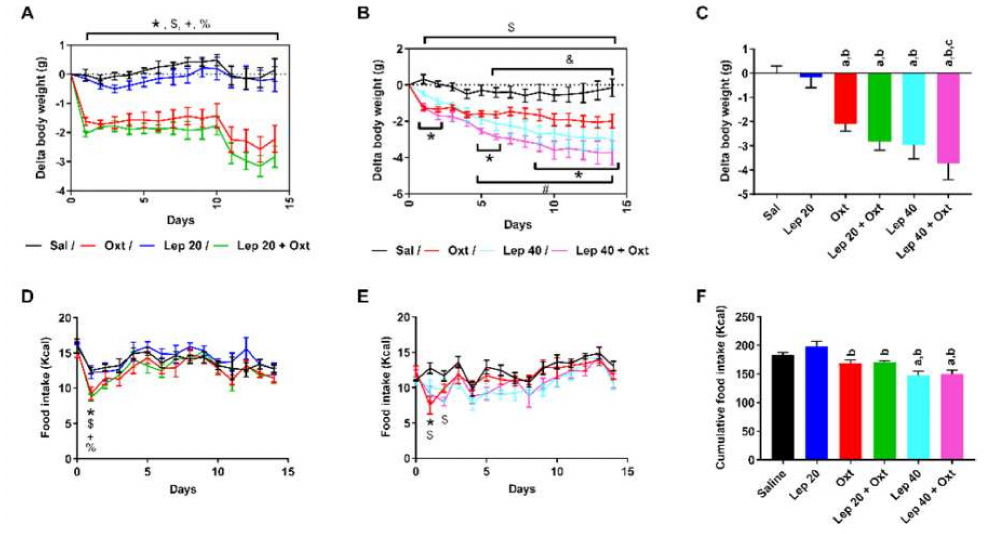
Figure 2. Effects of chronic oxytocin and leptin treatment on body weight and food intake. ( A , B ) Delta body weight of HFD mice treated subcutaneously with minipumps infusing saline, oxytocin (50 µ g/day), leptin (20 µ g/day) ( A ) or (40 µ g/day) ( B ), leptin plus oxytocin (20 µ g/day and 50 µ g/day, respectively) ( A ) or (40 µ g/day and 50 µ g/day) ( B ). ( C ) Delta body weight at the end of the treatment for the indicated groups. ( D – F ) Daily ( D , E ) and cumulative ( F ) food intake for the indicated groups. For ( A , B ) and ( D , E ), statistical significance was analyzed by two way repeated measures ANOVA with a FDR Benjamini and Hochberg’s post-hoc test. For ( C ) and ( F ), statistical significance was analyzed by one-way ANOVA with a FDR Benjamini and Hochberg’s post-hoc test. For ( A , B ) and ( D , E ): n = 6–8, * p < 0.05, Sal vs. Oxt; # p < 0.05, Sal vs. Lep; $ p < 0.05, Sal vs. Lep+Oxt; and p < 0.05, Oxt vs. Lep+Oxt; + p < 0.05, Lep vs. Lep+Oxt; % p < 0.05, Lep vs. Oxt. For ( C , F ), n = 6–16, a, p < 0.05 vs. Sal; b, p < 0.05 vs. Lep 20 µ g/day; c, p < 0.05 vs.